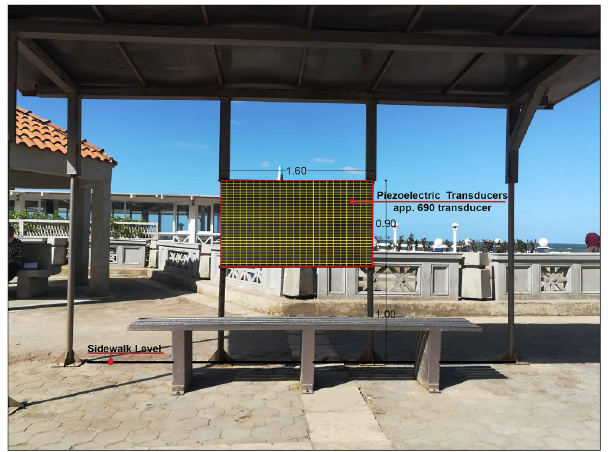
Fig 13. The proposed area to place the piezoelectric transducers at the bus stop of Cleopatra Station as an example. The area is about 1.45 m 2 and it takes about 690 QB220-503YB transducers to cover this selected area (Researcher, 2018).